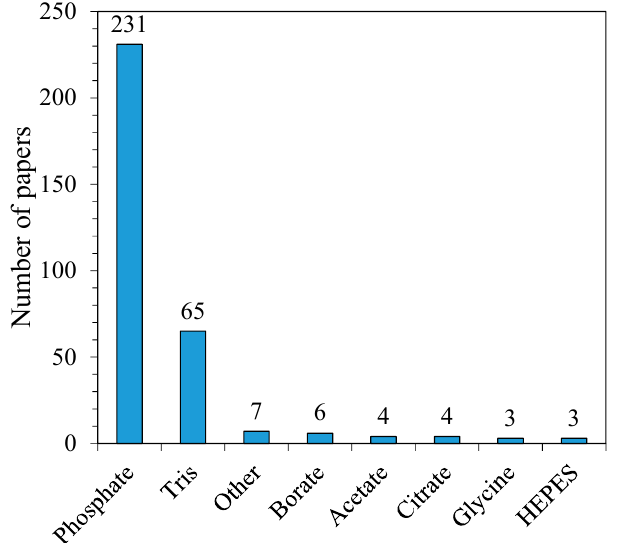
Figure 4. Buffer solutions used to study albumin–ligand binding by a number of the original papers cited in the dataset.